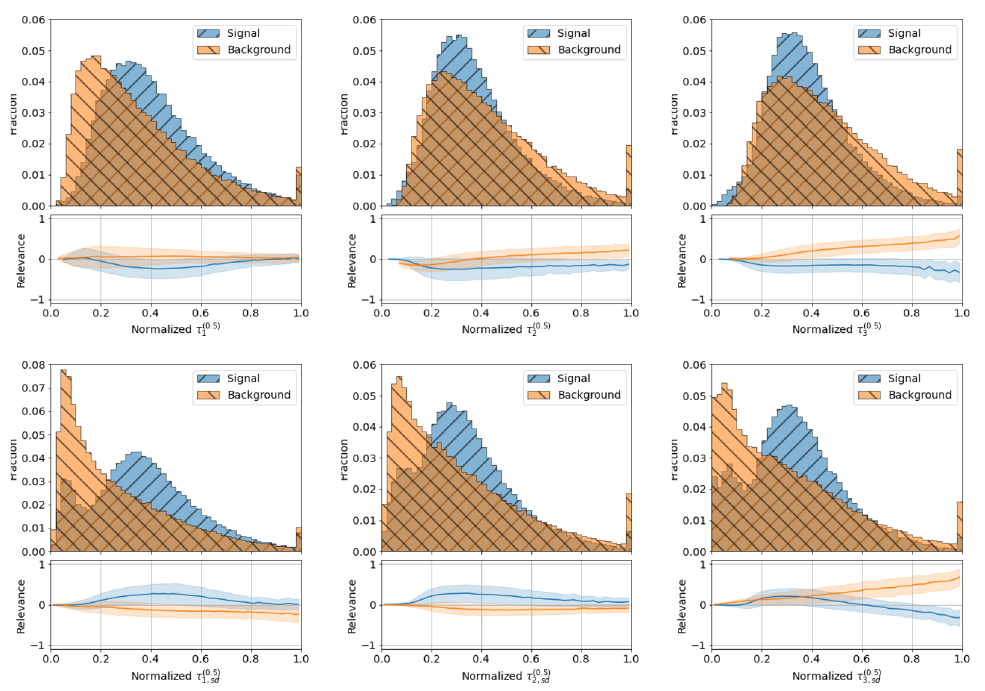
Figure 27. Histograms with profiles of normalized LRP